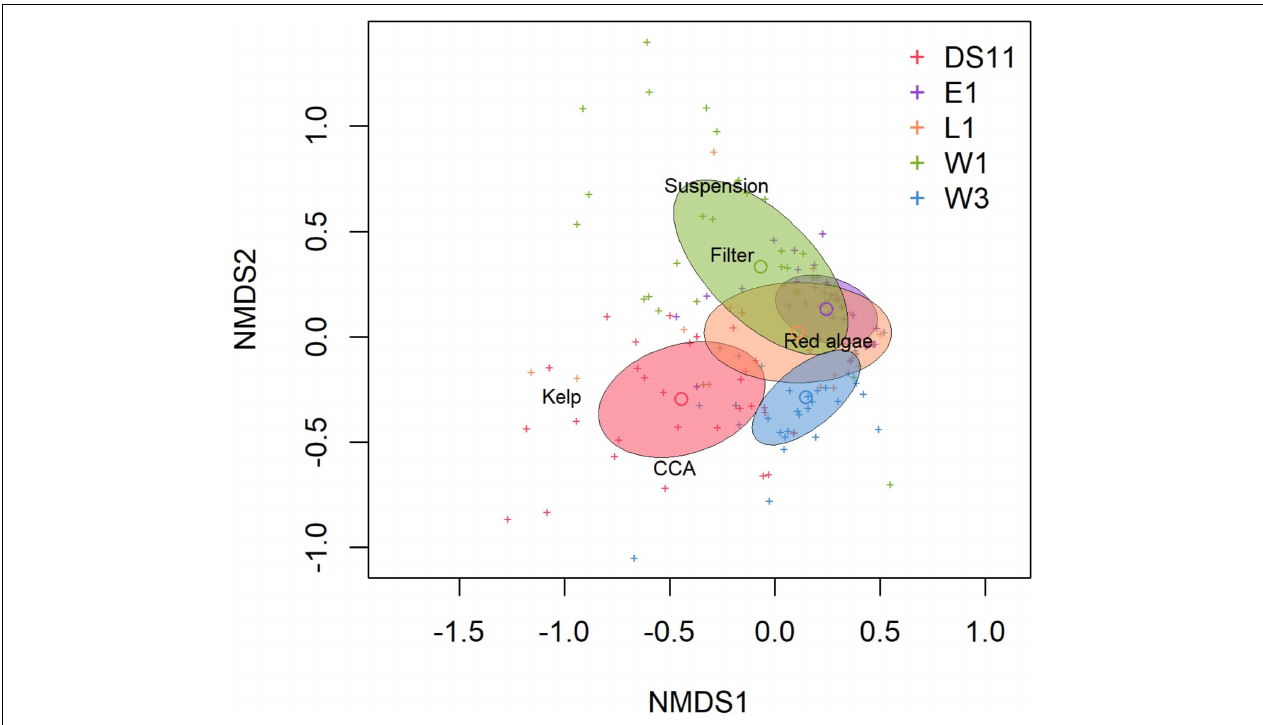
FIGURE 4 | Non-metric multidimensional scaling plot (Bray-Curtis matrix, square-root transform) of benthic community structure by functional group at each site. Center circle in ellipses indicate median community structure; ellipse area indicates standard deviation. Crosses indicate individual photoquadrats. Functional groups names represent their vector of percent cover, such that crosses furthest in that direction have the highest percent cover of that group. 2D stress =